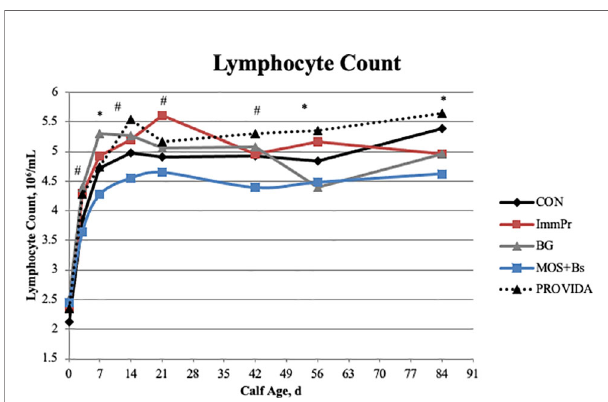
FIGURE 7 | Lymphocyte count was measured on d 0, 3, 7, 14, 21, 42, 56, and 84. There was a treatment x time interaction ( P ≤ 0.003). The MOS+Bs treatment had decreased lymphocytes when compared to other treatments; MOS+Bs vs. CON ( P ≤ 0.079) on d 42, and 84; MOS+Bs vs. ImmPr ( P ≤ 0.068) on d 3, 7, 14, 21, 42, and 56; MOS+Bs vs. BG ( P ≤ 0.05) on d 3, 7, 14, and 42; MOS+Bs vs. PROVIDA ( P ≤ 0.042) on d 3, 14, 42, 56, and 84. Largest SEM per time point are expressed as 10 6 /mL and include 0.183, 0.229, 0.237, 0.263, 0.244, 0.230, 0.214, and 0.231 for d 0, 3, 7, 14, 21, 42, 56, and 84, respectively. An * indicates a treatment difference of ( P ≤ 0.05) and a # indicates a tendency for a treatment difference (0.05 < P ≤ 0.10) when treatments were sliced by time.